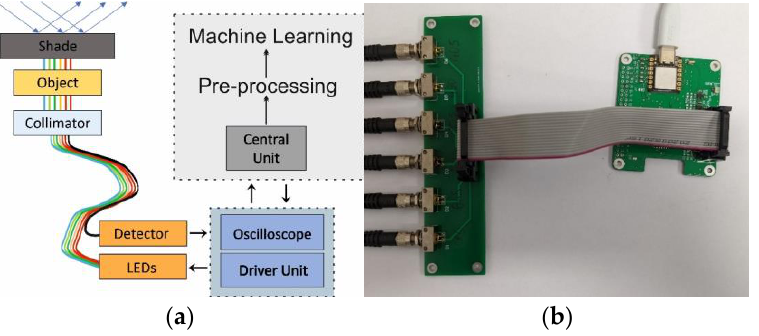
Figure 8. Scheme of the reflectometer system with indicated optical and electrical signals flows ( a ) and an image of driver unit with integrated LEDs and fan-out SMA input connectors ( b